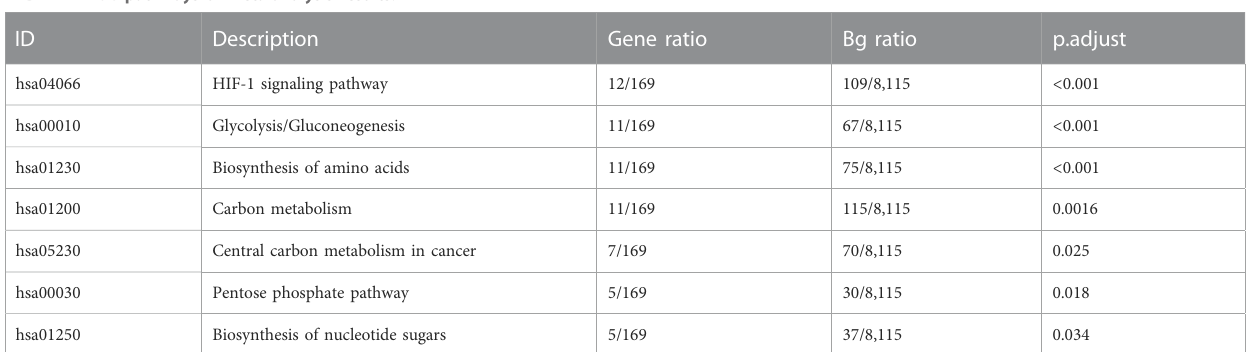
TABLE 1 KEGG pathways of meta-analysis